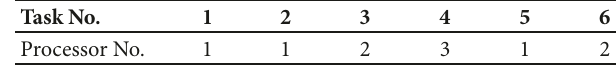
Table 1: Classic chromosome structure for a sample DAG. Task No. Processor